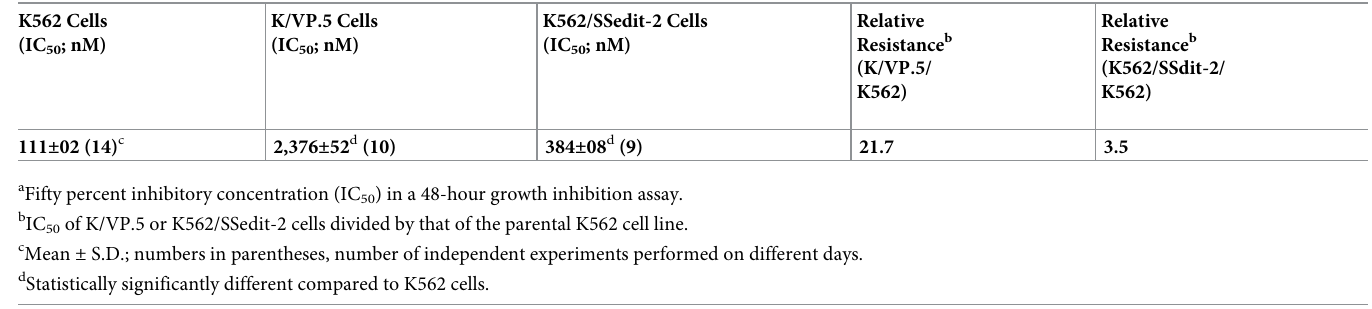
Table 1. Growth inhibitory effects of etoposide in K562, K/VP.5, and K562/SSedit-2 cells.